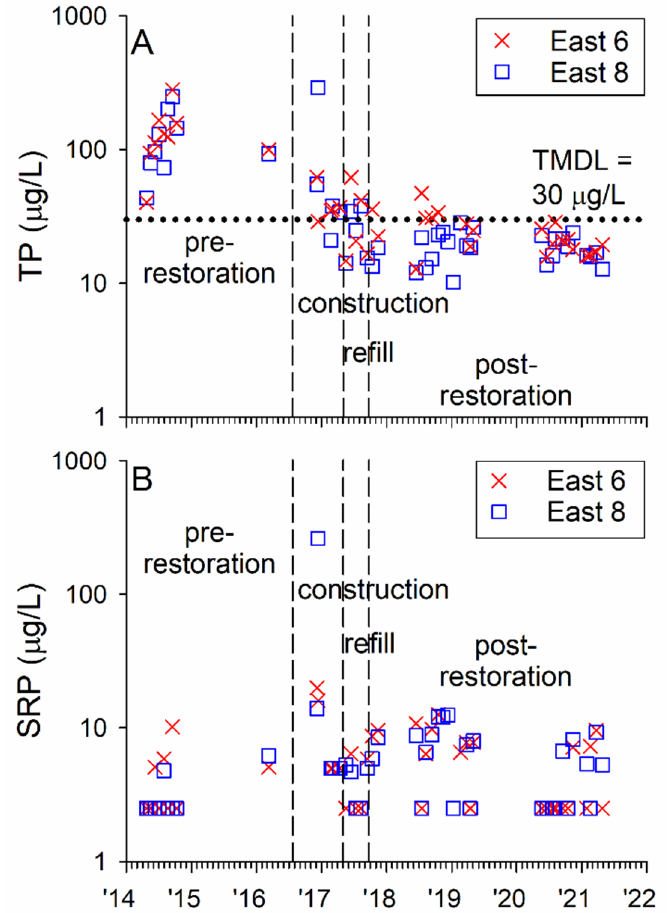
Figure 5. East pond TP ( A ) and SRP ( B ) site concentrations over 2014–2021 monitoring period, divided into restoration phases. Reference line at 30 μg/L represents TP target goal set by the Bear Lake TMDL [26]. Note the log scale y -axis. Table 2. East pond sites’ (6 and 8) means ( ± SD) and pre- vs. post-restoration general water